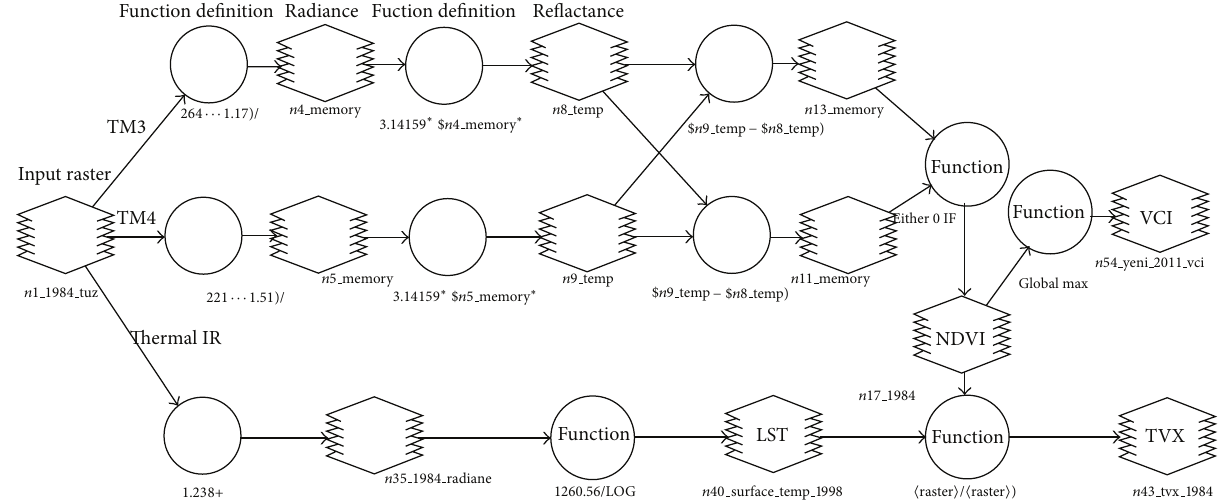
Figure 3: Presentation of flow chart used for producing vegetation index by using Modeler algorithm of ERDAS Imagine image processing software.